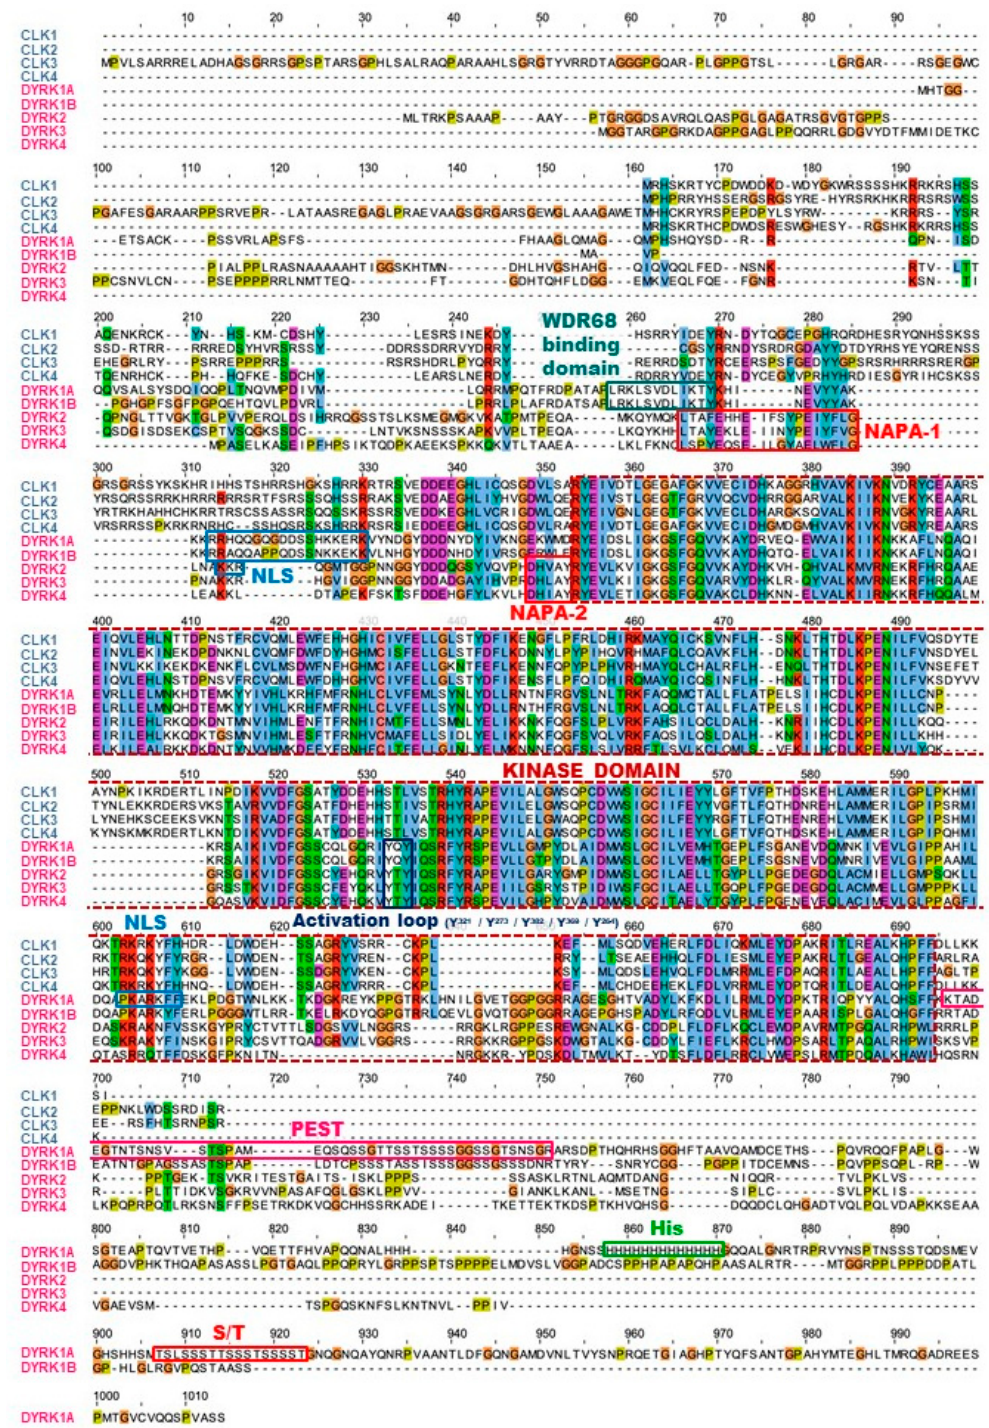
Figure 4. Sequence alignment of human DYRKs and CLKs. Multiple sequence alignment of the canonical sequences of DYRK and CLK members was performed using Clustal Omega [41] (https://www.ebi.ac.uk) (accessed on 12 April 2021) and edited using Jalview [42]. Each residue in the alignment is assigned a colour if the amino acid profile of the alignment at that position meets some minimum criteria specific for the residue type (Clustal X Colour Scheme, http://www.jalview.org/help/html/colourSchemes/clustal.html) (accessed on 12 April 2021). Distinct sequences are indi- cated: Activation loop and tyrosine residue that is autophosphorylated (Yn); DH, DYRK homology box; His domain, 13 consecutive histidine residues region; kinase domain; NAPA, N-terminal autophosphorylation accessory domain; NLS, nuclear localization signal domain (NB: a NLS sequence is only found in isoform 4 of DYRK4, not in the canonical se- quence); PEST, proline (P), glutamic acid (E), serine (S), and threonine (T)-rich domain; S/T, serine, and threo- nine-enriched domain; WDR68 binding domain.